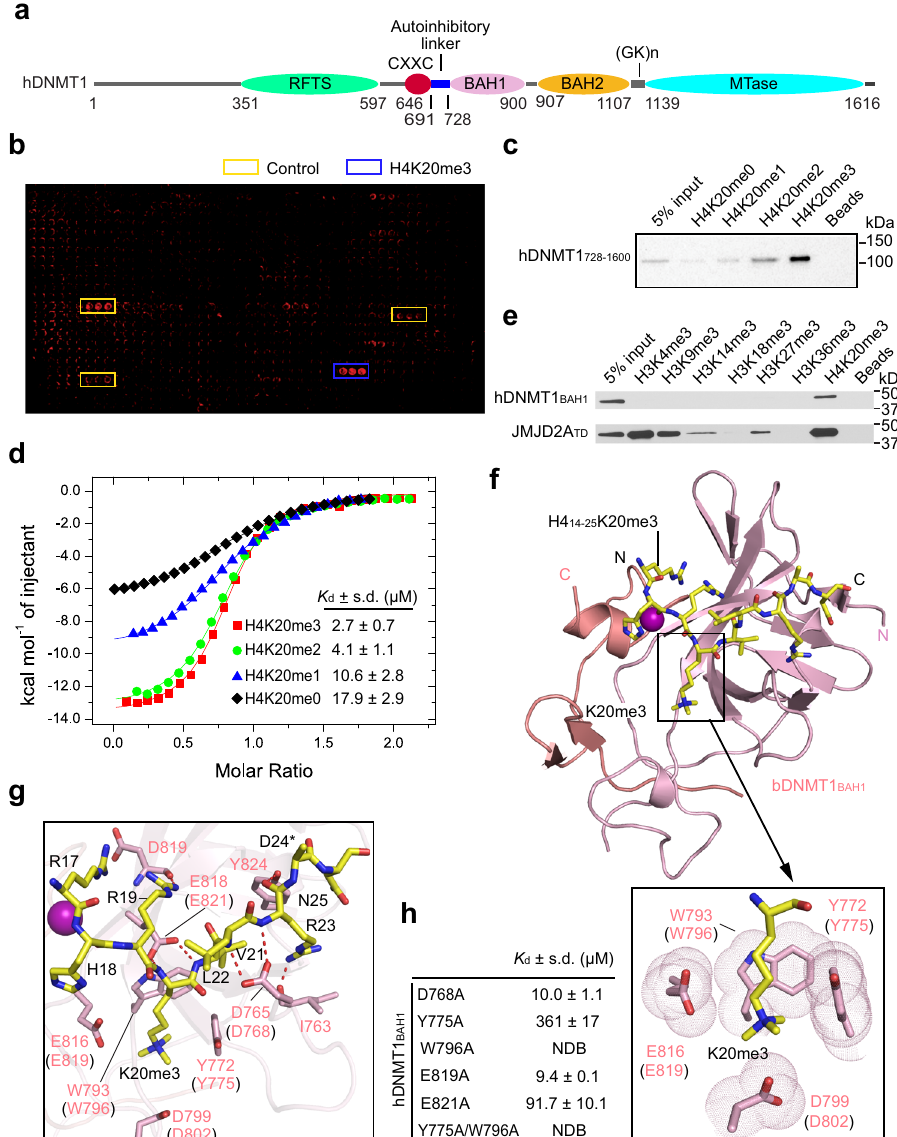
Fig. 1 Biochemical and structural analysis of the DNMT1 BAH1 – H4K20me3 interaction. a Domain architecture of human DNMT1 (hDNMT1), with individual domains delimited by residues numbers. b Histone peptide array analysis of the interactions between hDNMT1 728 – 1600 and histone peptides. c Peptide pull-down analysis of the interactions of hDNMT1 728 – 1600 with different H4K20me peptides. The experiment was repeated three times with consistent results. d ITC-binding assays for hDNMT1 BAH1 , titrated with different H4K20me peptides. e Peptide pull-down analysis of the interactions between hDNMT1 BAH1 and different tri-methylated histone peptides. The experiment was repeated three times with consistent results. f Crystal structure of bDNMT1 BAH1 (light pink) and H4 14 – 25 K20me3 peptide (yellow), with the H4K20me3-binding pocket shown in the expanded view (boxed). The last two β -strands, which were domain-swapped during crystallization, are colored in salmon. The zinc ion is shown as a purple sphere. g Close-up view of the intermolecular interactions between bDNMT1 BAH1 and the H4 14 – 25 K20me3 peptide. The equivalent pocket residues in hDNMT1 BAH1 are labeled in parentheses in ( f , g ). The hydrogen bonds are shown as dashed lines. *The side chain of H4 D24, except for the C β atom, is untraceable. h K d values of hDNMT1 BAH1 mutants and H4 14 – 25 K20me3 peptides, derived from the ITC binding assays. NDB, no detectable binding. Source data are provided as a Source Data fi Structural details for the Interaction between DNMT1 BAH1 g). The H4 14 – 25 K20me3 peptide extends along one end of the β - Domain and H4K20me3 . To understand the structural basis for barrel (Fig. 1f), with the side chain of H4K20me3 inserted into a the DNMT1 BAH1 – H4K20me3 interaction, we determined the pocket formed by Y772, W793, D799, and E816 of bDNMT1 BAH1 (Fig. 1f, boxed). Flanking the H4 14 – 25 K20me3 peptide, the side crystal structure of the BAH1 domain of bovine DNMT1 chains of bDNMT1 BAH1 D765 and E818 each form a bidentate (bDNMT1 BAH1 ), which shares ~94% sequence identity with hDNMT1 BAH1 (Supplementary Fig. 1e), in complex with the hydrogen bond with the backbone amides of H4, and the back- H4 14 – 25 K20me3 peptide at 2.65 Å resolution (Fig. 1f and Table 1). bone of bDNMT1 BAH1 D765 is further hydrogen bonded to the The structure of bDNMT1 BAH1 reveals a twisted β -barrel side chain of H4 R23 (Fig. 1g). Additional intermolecular inter- resembling hDNMT1 BAH1 (Fig. 1f and Supplementary Fig. 1f, actions involve bDNMT1 BAH1 I763, D819, and Y824 and H4 R17,